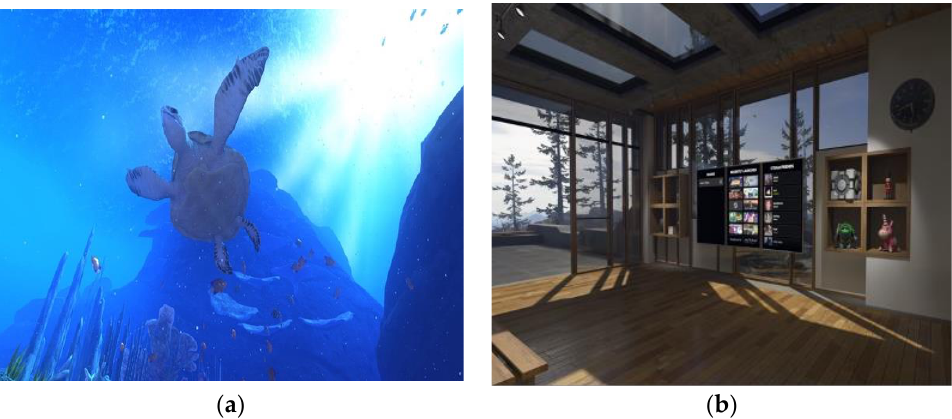
Figure 2. Screenshots of some virtual scenarios proposed for first contact with IVR: ( a ) Seabed and turtles in TheBlue experience; ( b ) inside the mountain house in Steam VR Home .